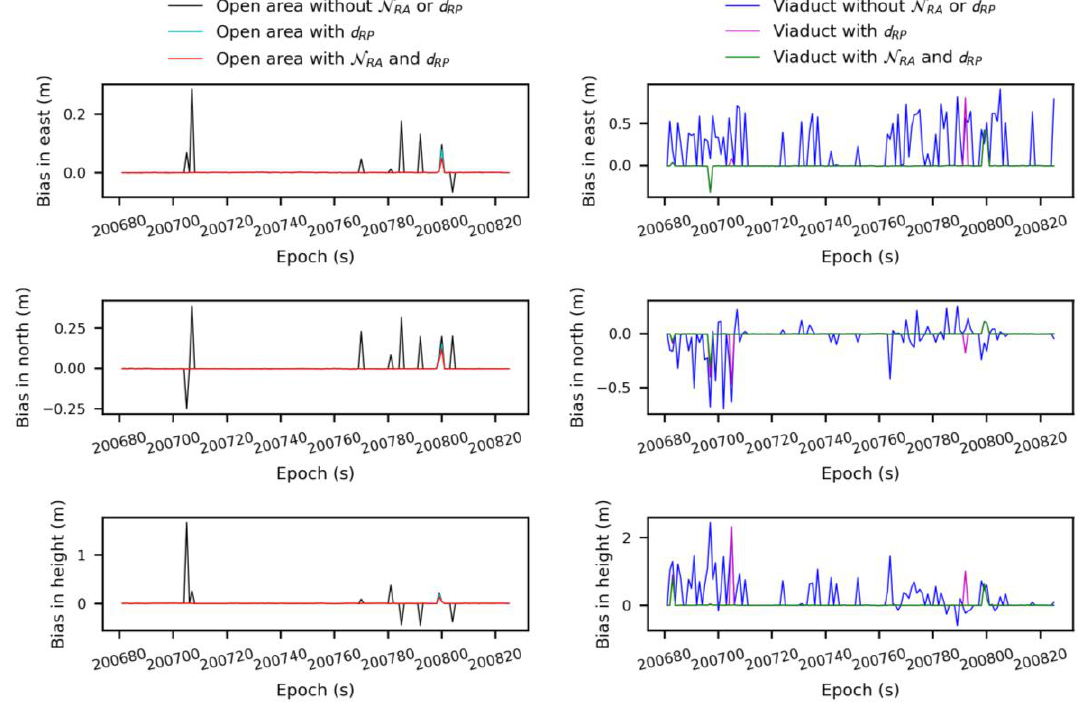
Figure 11. Positioning errors in east, north and height directions of the vehicle 2 in the absolute positioning for six cases.